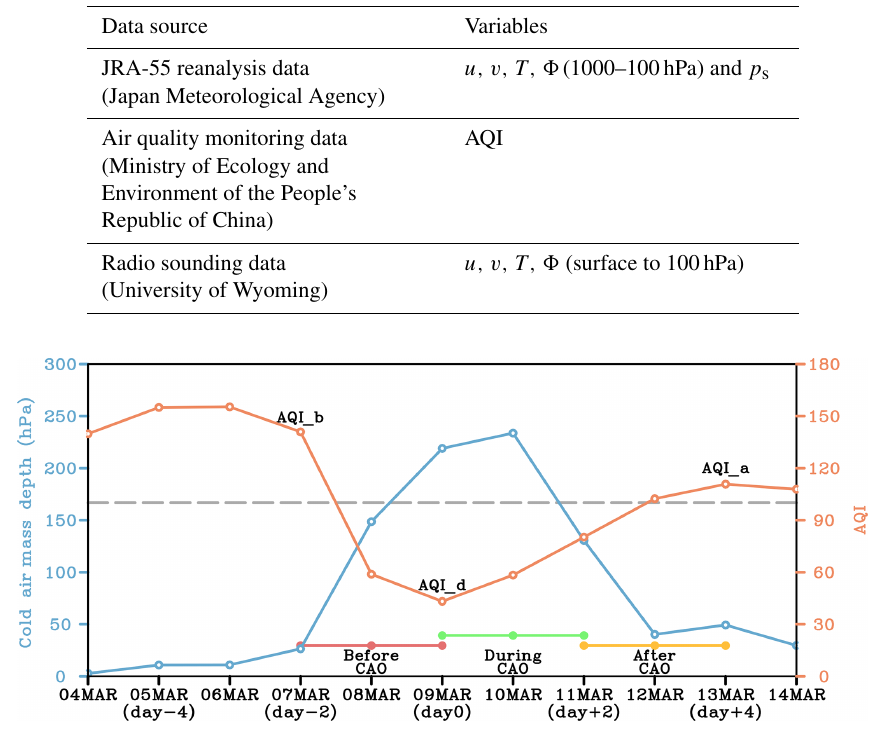
Figure 1. Time series of the regional averaged cold air mass depth (blue line) and AQI (orange line) in NEC (114–122 ◦ E, 30–40 ◦ N). The gray dashed line denotes the threshold value of the cold air mass